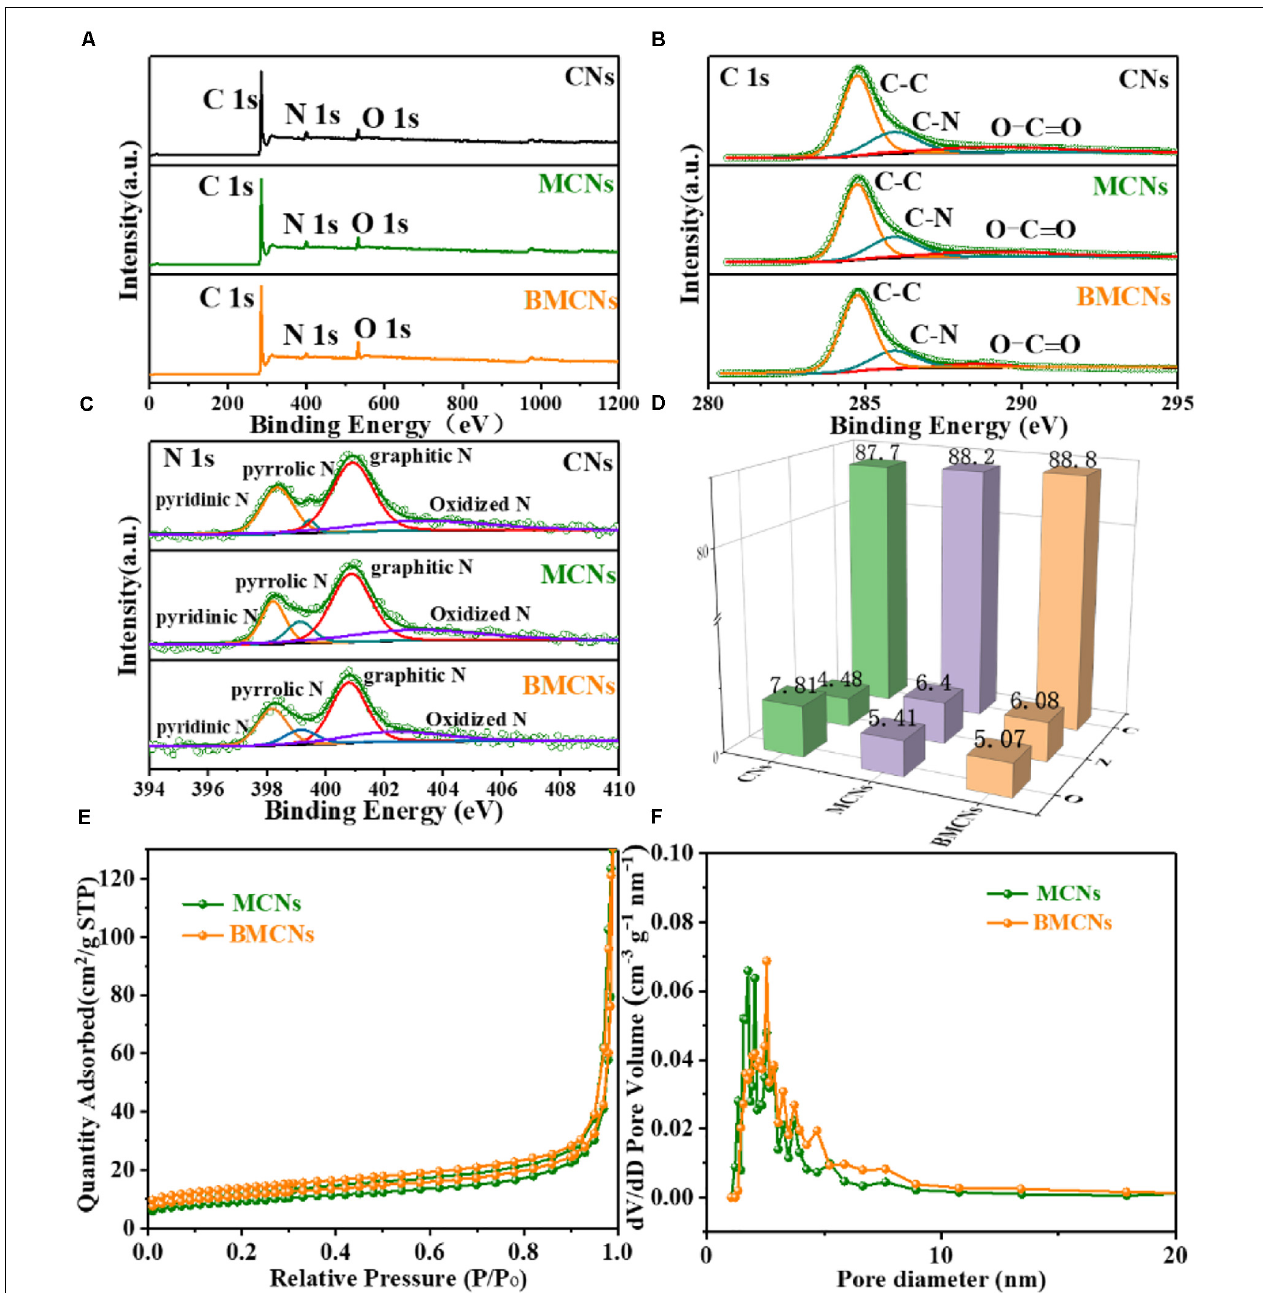
FIGURE 2 | XPS spectra for CNs, MCNs, and BMCNs: (A) Survey spectrum and high-resolution spectra of (B) C 1s, (C) N 1s, and (D) atomic ratio. (E) N 2 adsorption/desorption isotherms of MCNs and BMCNs, (F) pore size distribution.